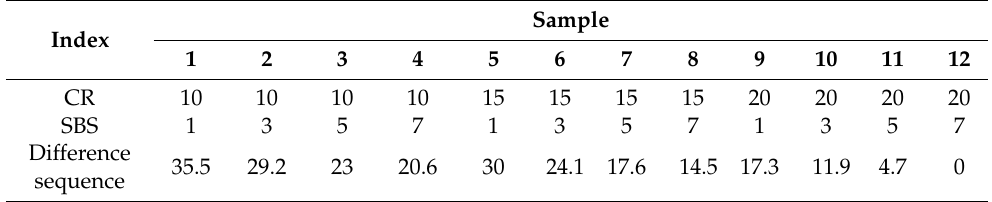
Table 4. The grey correlation coefficients under different contents were calculated, and the results are listed in Table 5. Table 4. The difference sequences of CR and SBS.